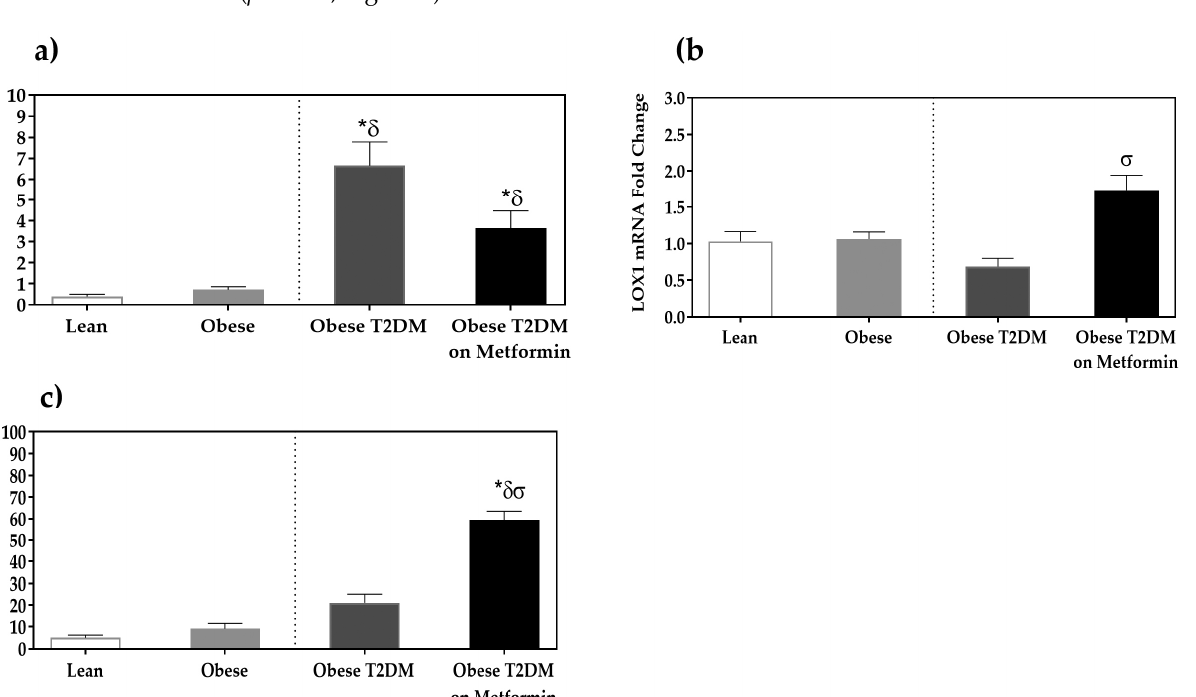
Figure 5. mRNA expression of adenosine receptors in the PBMCs of lean, obese, T2DM and T2DM on Metformin groups: ( a ) A2AR; and ( b ) A3R. Results are presented as Mean ± SEM. One ‐ way ANOVA on ranks, p < 0.001 for A2AR, and A3R, followed by Dunn’s test for pairwise comparisons and comparisons against normal ‐ weight group, * p < 0.05 vs. normal ‐ weight subjects; δ p < 0.05 vs. obese; σ p < 0.05 vs. T2DM subjects.